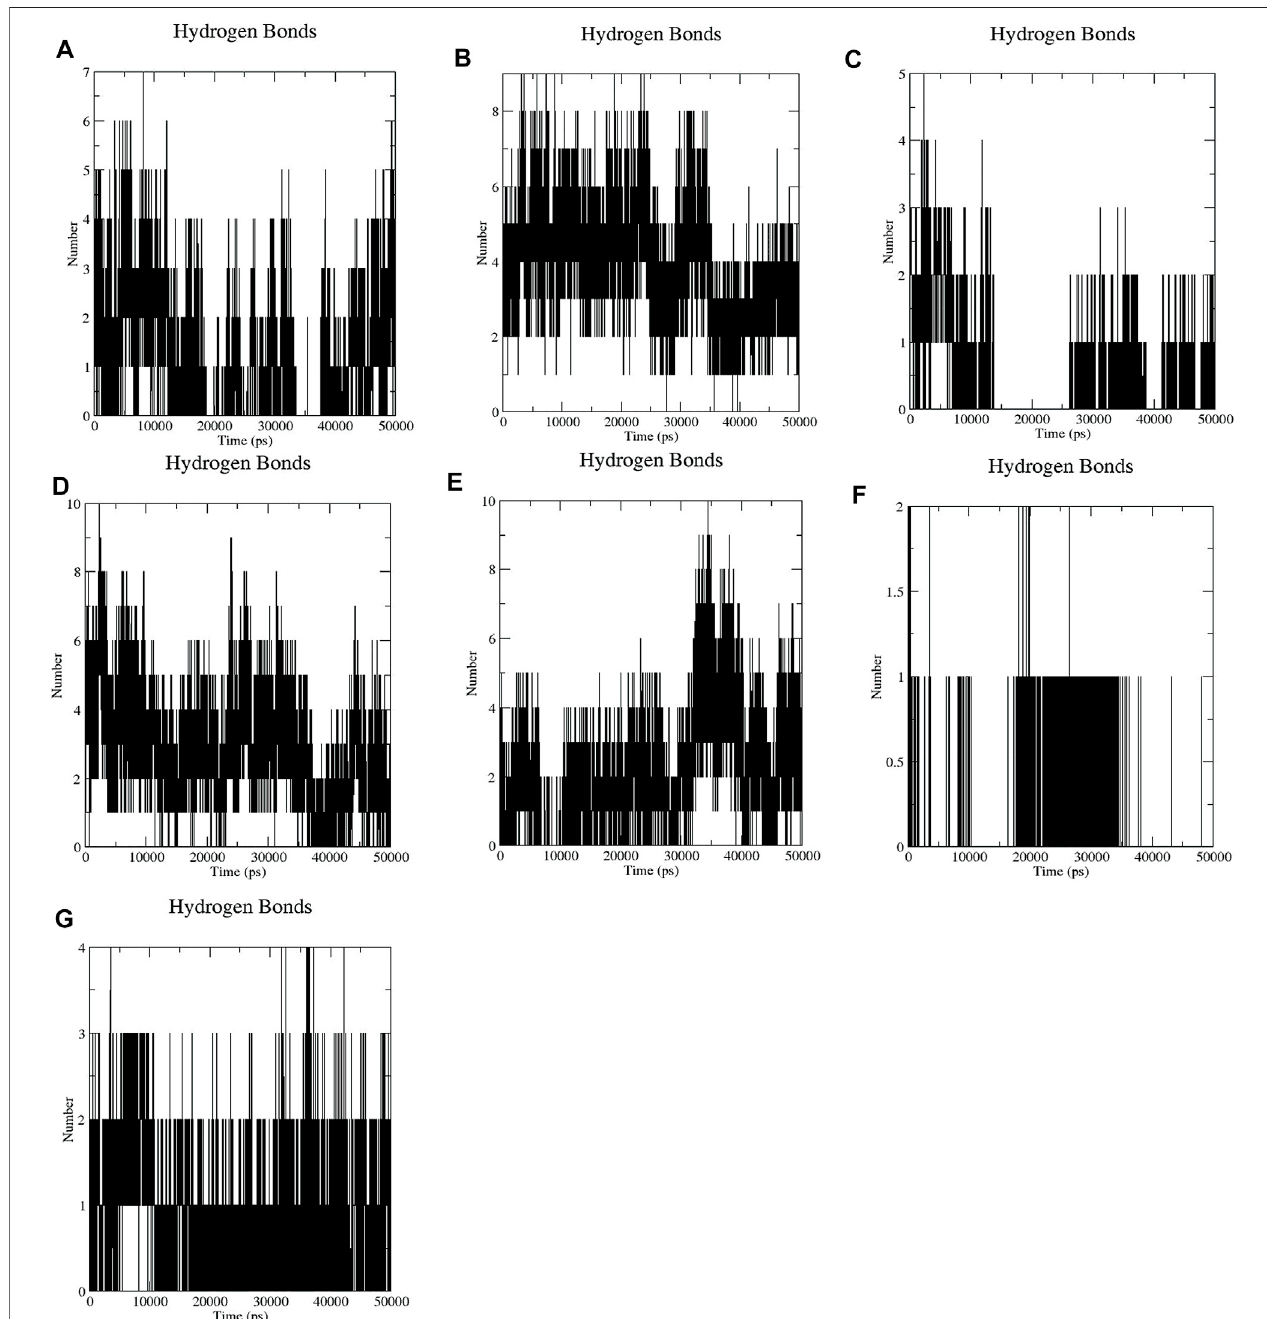
FIGURE 3 | Intermolecular hydrogen bond plots of compounds (A) GA, (B) CA, (C) TQ, (D) Betanin, (E) Betanidin, (F) Ebselen, and (G) Fisetin.